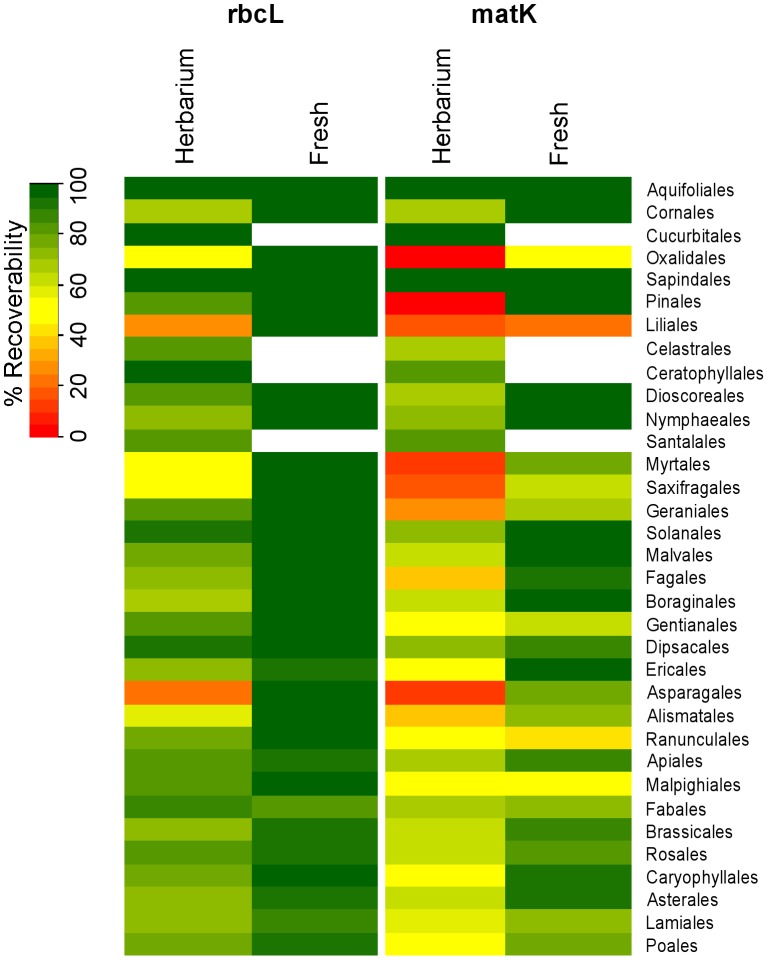
Recoverability of the orders of flowering plants and conifers found within Wales using herbarium and fresh material.Recoverability (%) of rbcL and matK across the 34 orders of seed plants found within the Welsh flora. Results are based on 3637 herbarium and 635 freshly collected specimens. White cells denote orders for which fresh specimens were not collected.